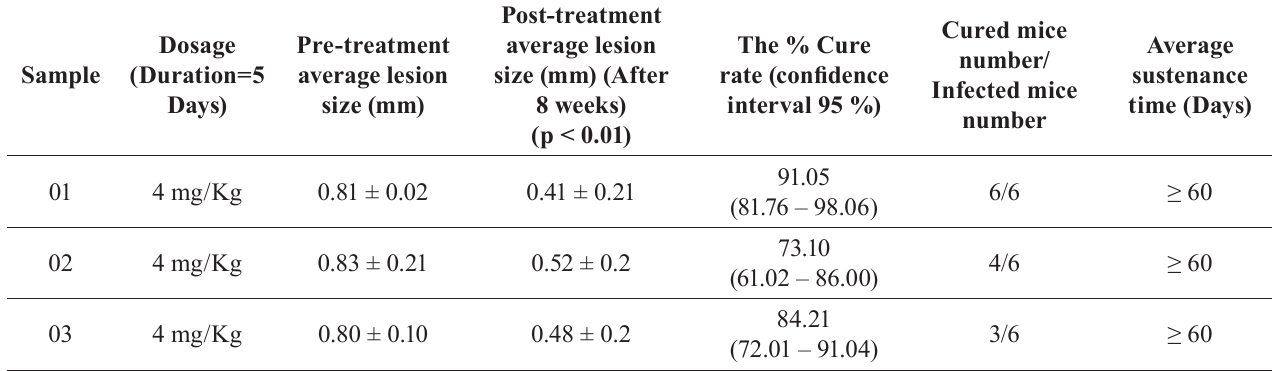
TABLE II - Compounds in vivo anti-leishmanial effect. Table shows the average lesion size in mm ±